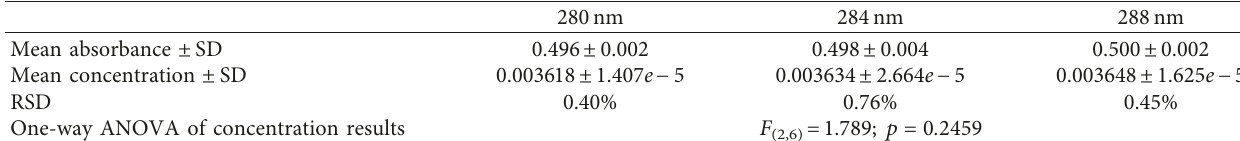
Table 5: Robustness of developed method at three different